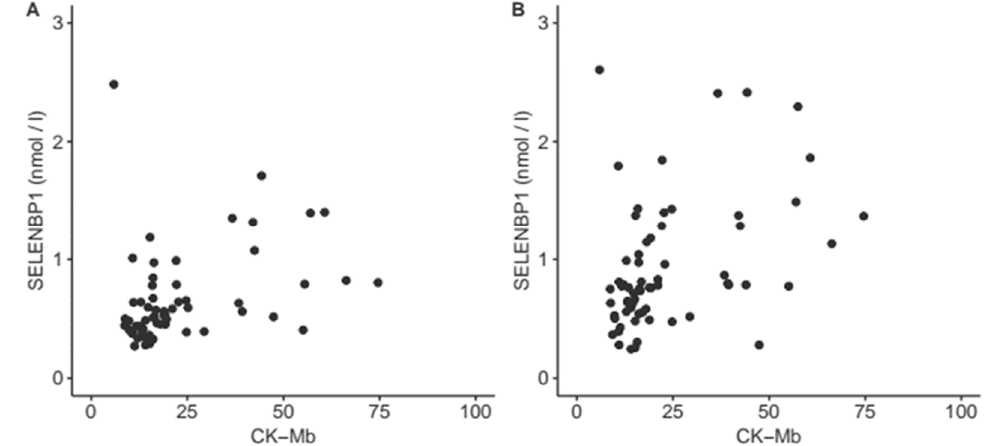
Figure 5. Correlation of intraoperative serum SELENBP1 concentrations with heart-specific creatinine kinase (CK-MB) after surgery. Serum SELENBP1 measured during intervention and heart-specific CK-MB concentrations measured after intervention display a positive correlation, both to the SELENBP1 concentrations measured at ( A ) 2 min after reperfusion ( ρ = 0.5, p < 0.0001), and at ( B ) 15 min after weaning from the CBP ( ρ = 0.4, p = 0.0007), respectively.